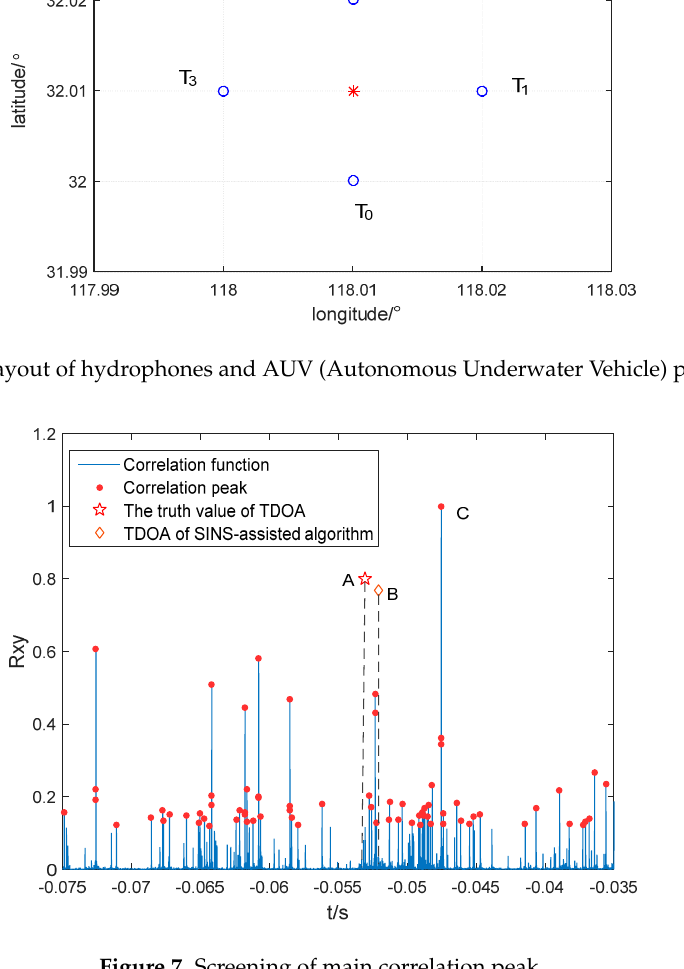
Figure 7. Screening of main correlation peak. Table 1. Comparison of TDOA (Time Difference of Arrival) calculation error.